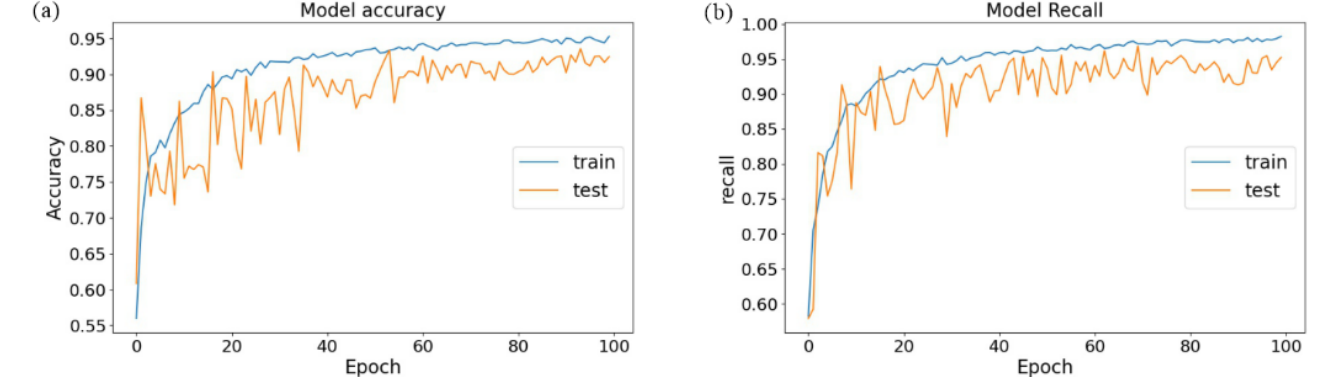
Figure 9. Acc and R evaluation index curves of UNet. ( a ) Acc ; ( b ) R .